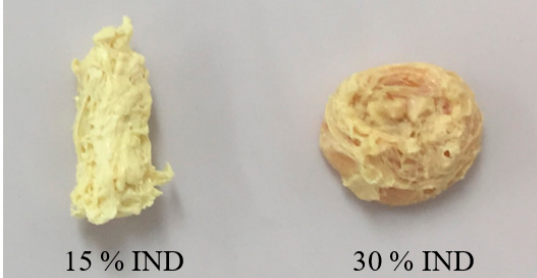
Figure 8. The physical appearance of post-dissolution injection moulded tablets of PVPVA-IND solid dispersions in pH 1.2 dissolution medium.